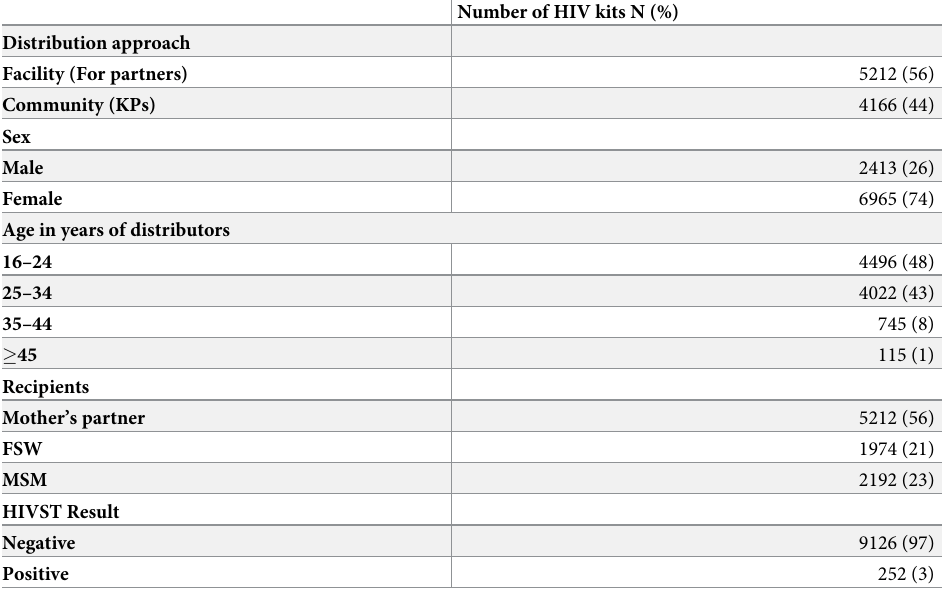
Table 1. Characteristics of the distributors and recipients of HIV self-test kits (9378) in Kampala, Uganda (Octo- ber 2018–June